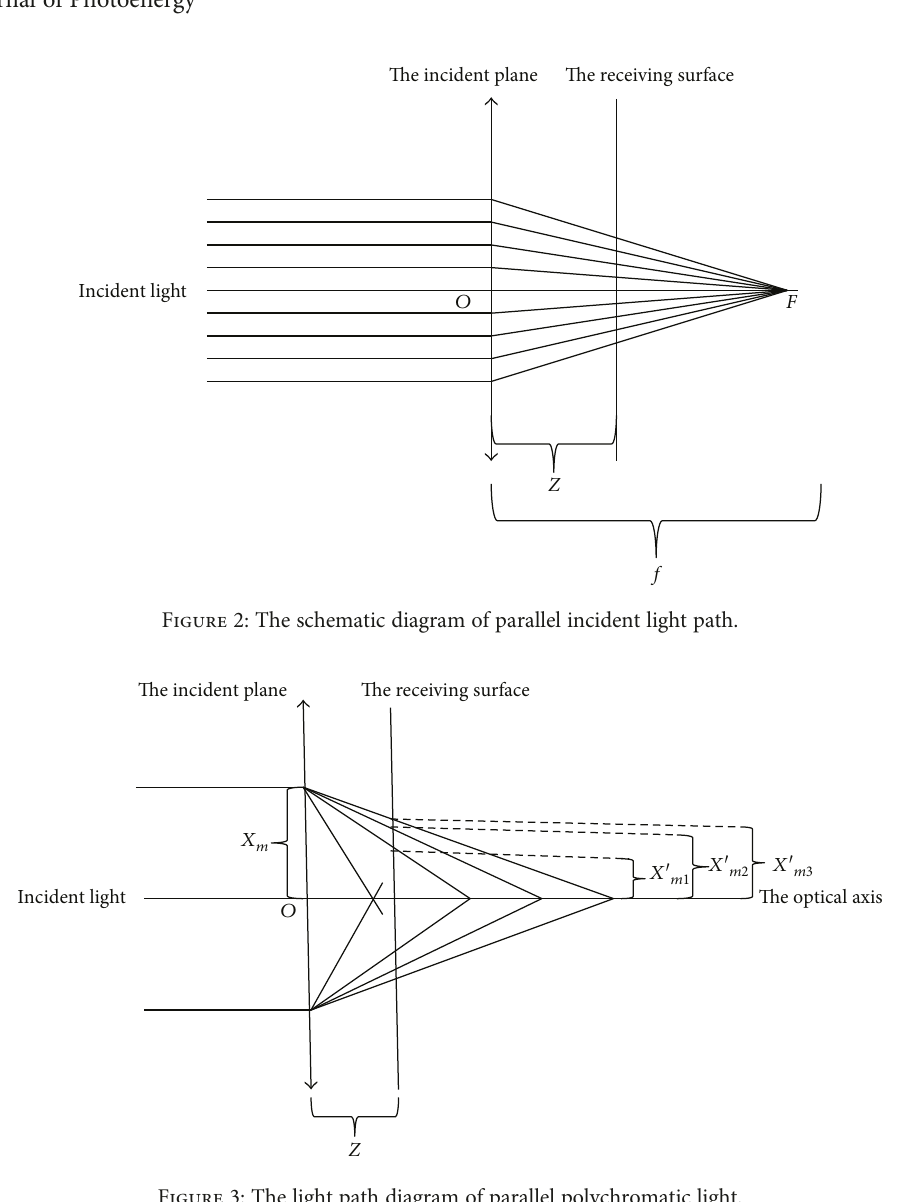
Figure 3: The light path diagram of parallel polychromatic light.